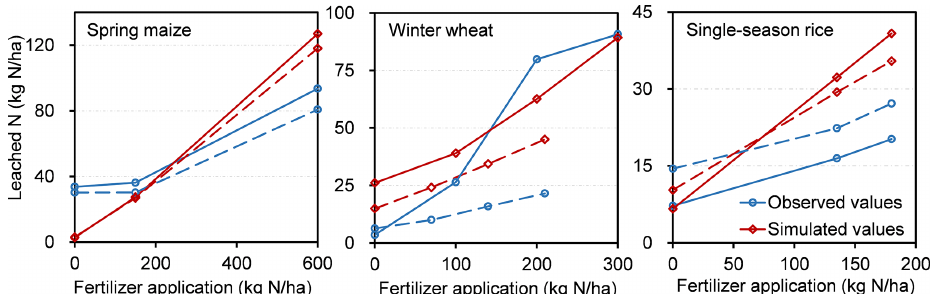
Figure 3. The simulated and observed responses of the leached nitrogen to different levels of fertilizer application rates for three main crop types (i.e., maize, rice, and wheat) over the Yangtze Plain. Note that the solid and dotted lines represented two different pairs of simulated and observed responses of leached nitrogen, respectively.